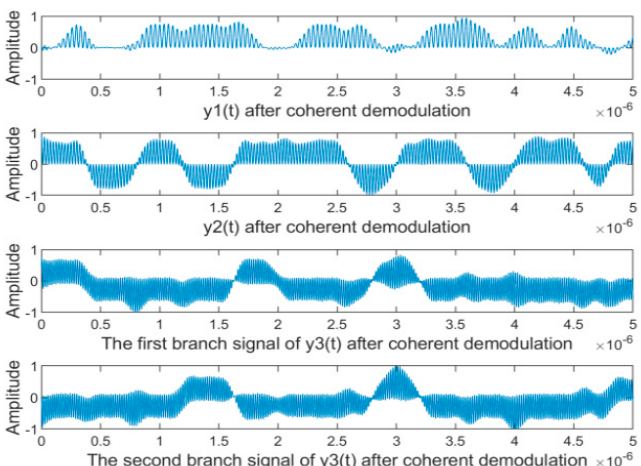
Figure 12. The waveforms of separated signals after coherent demodulation.